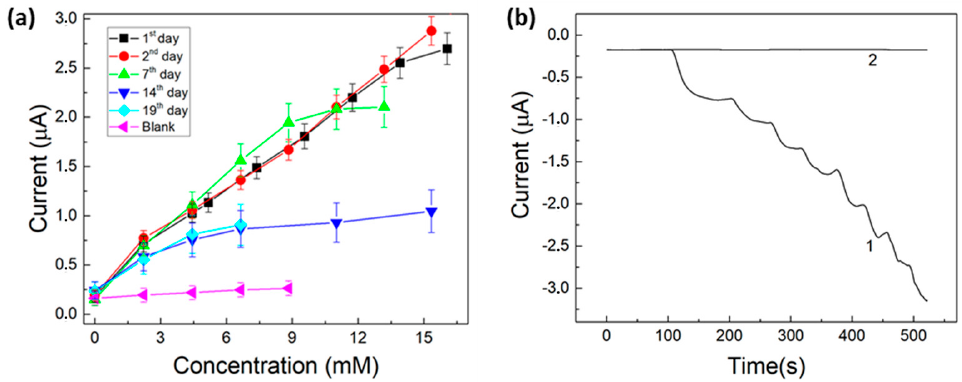
Figure 4. ( a ) Clark-type LDH-catalase enzyme biosensor. Amperometric calibration curves recorded by increasing H 2 O 2 concentration as a function of lifetime. Each point represents the mean of at least three repeated determinations. ( b ) Raw experimental data of a typical calibration curve of the fabricated Clark-type LDH-catalase enzyme biosensor, recorded as a function of time (2nd day) under subsequent additions of hydrogen peroxide solution (curve 1), and blank curve without enzyme (curve 2). Each addition was 0.05 mL of H 2 O 2 (0.3% by weight) water solution.